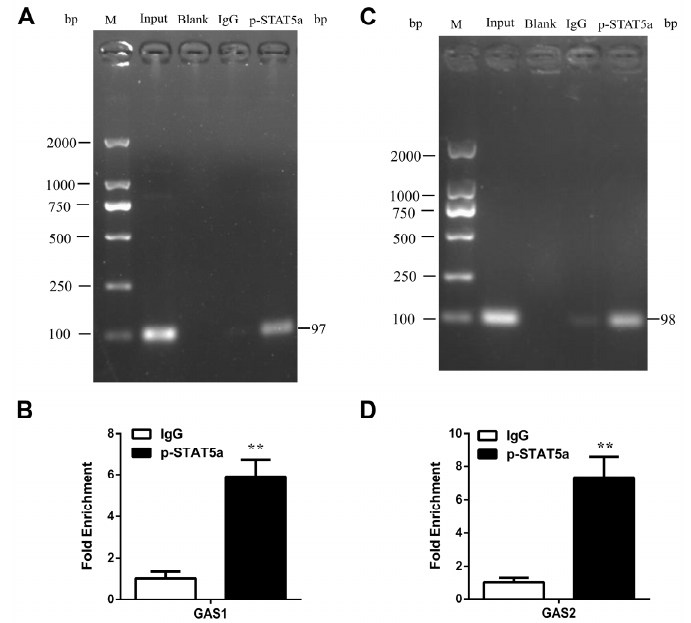
Figure 7. Transcription of the CSN1S1 gene is regulated by direct STAT5 binding to GAS sites in GMEC. ( A ) GAS1 and ( C ) GAS2 binding sites in CSN1S1 promoter region were recognized by STAT5 directly using chromatin immunoprecipitation (ChIP)-PCR analysis. ( B ) GAS1 and ( D ) GAS2 binding sites in the CSN1S1 promoter region were recognized by STAT5 directly using ChIP-qPCR analysis. Data are shown as means ± SEM for 3 biological replicates. ** p <